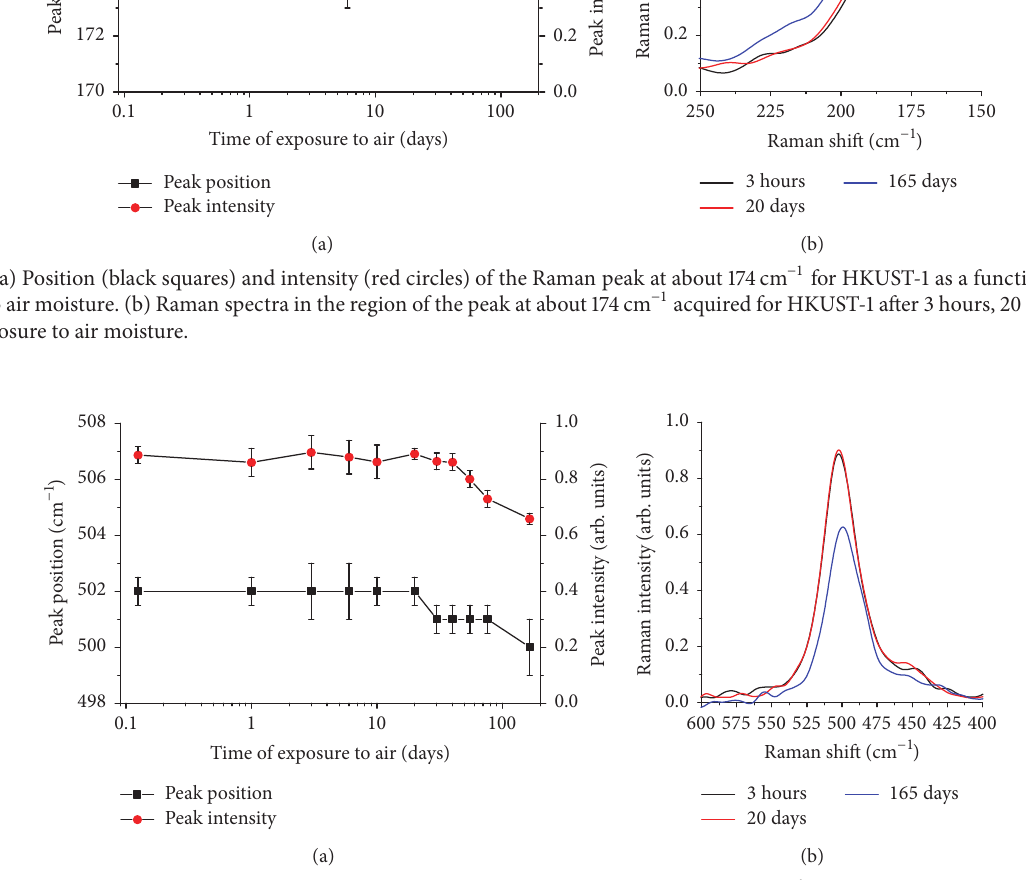
Figure 5: (a) Position (black squares) and intensity (red circles) of the Raman peak at about 502cm −1 for HKUST-1 as a function of time of exposure to air moisture. (b) Raman spectra in the region of the peak at about 502cm −1 acquired for the HKUST-1 after 3 hours, 20 days, and 165 days of exposure to air